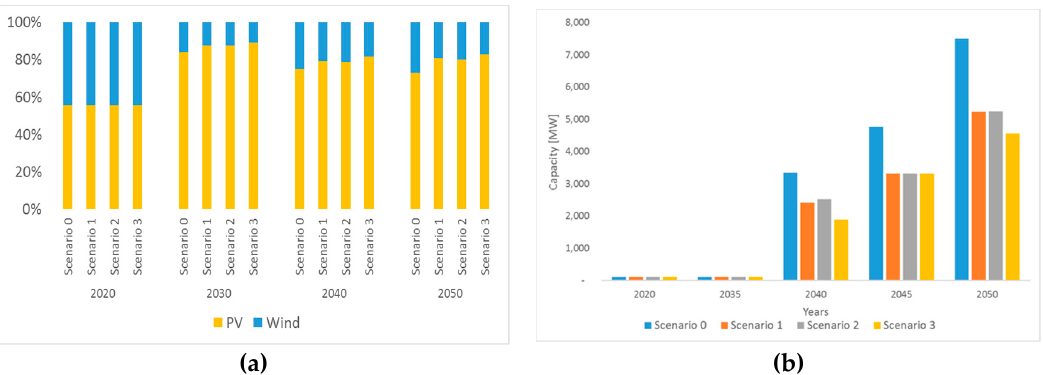
Figure 4. Relative evolution of PV and wind installed capacity per scenario ( a ) and evolution of the installed capacity of CSP ( b ).